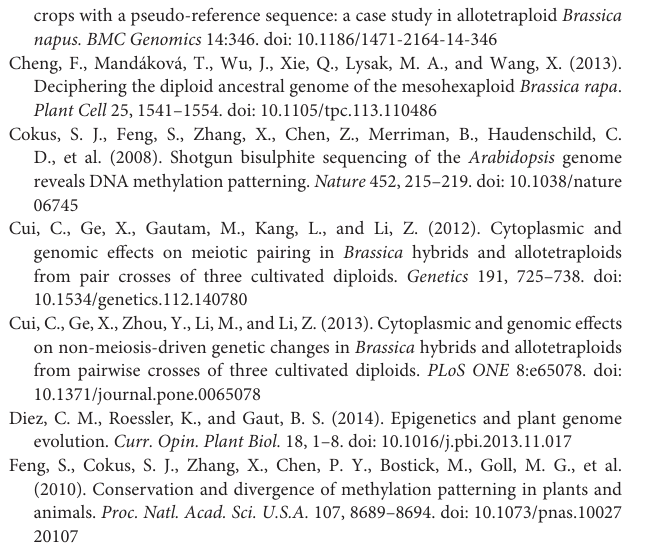
Table S1 | Characterization of gene expression with different copies or within different subgenomes. Table S2 | Summary of methylated loci and annotation. Table S3 | The relative proportion of genes transcribed at high, medium and low levels in different tissues of B. rapa . Figure S1 | The construction of a modified reduced representation bisulfite sequencing library. Figure S2 | The percentage of the three methylation contexts between whole genome and loci enriched using ( in silico ) mRRBS in (A) B. rapa and (B) rice ( Oryza sativa ). Figure S3 | The ratio of genome-wide methylation levels for CG, CHG and CHH contexts. Figure S4 | Mean CHG methylation levels in different components of genic regions (A) within the three subgenomes and (B) between genes of different copy number. Figure S5 | Mean CHH methylation levels in different components of genic regions (A) within the three subgenomes and (B) between genes of different copy number. Figure S6 | Mean methylation level of two-copy genes in three subgenomes of B. rapa. Figure S7 | Mean methylation level of three-copy genes in three subgenomes of B.